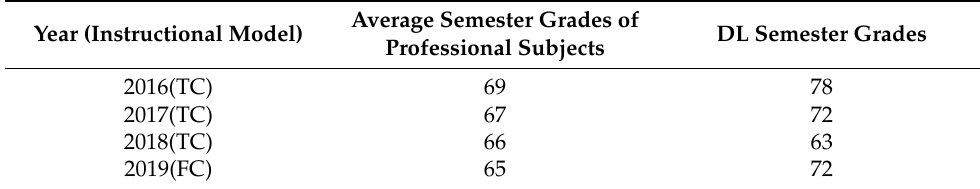
Table 3. Comparison between the average semester grades of professional subjects and DL semester grades 2016–2019.